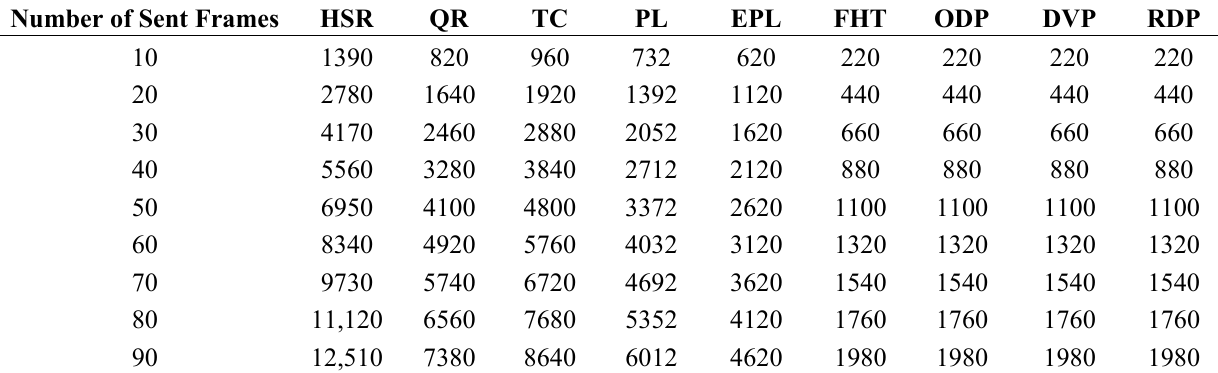
Table 3. The number of network traffic frames of traffic reduction